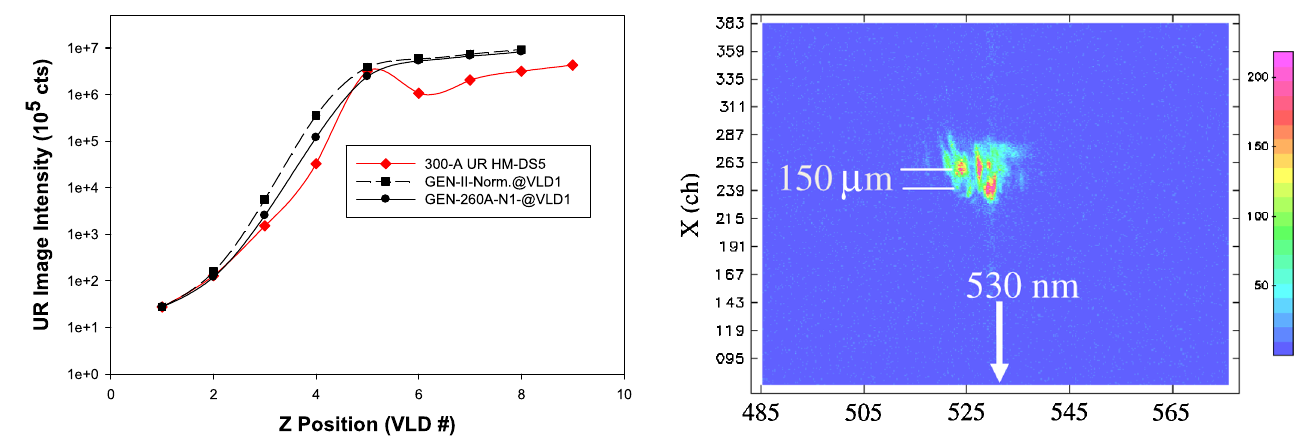
Fig. 14 the two enhancements are (cid:1) 150 (cid:1) m apart in x and (cid:1) 3 nm apart in wavelength near the nominal 530-nm